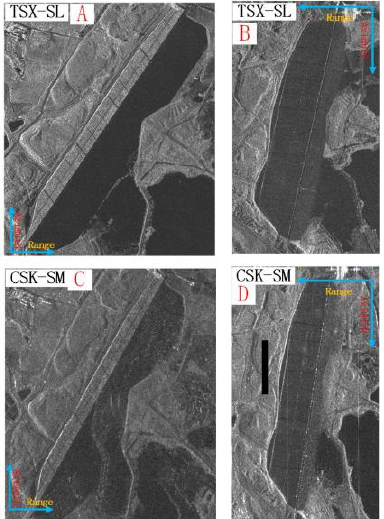
Figure 7. The dam surface foreshortening geometry on the ascending and descending images.